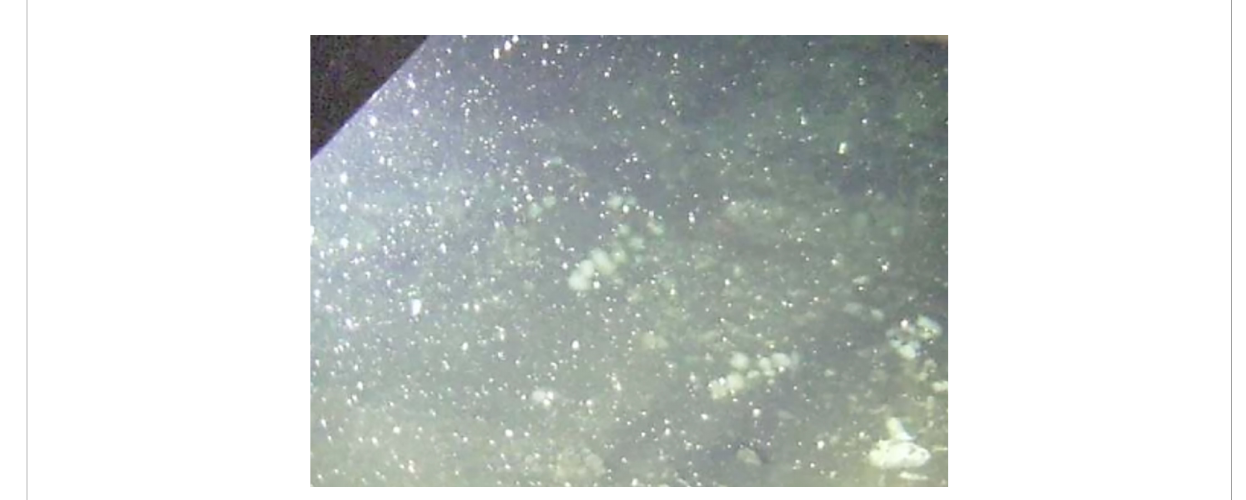
FIGURE 4 Lateral advection of disintegrated gelatinous particles, as an example of a rare biomass input from shallower waters. Note the technical dif fi culties in determining the depth of view and the shape of the particles, and as a result, the challenging estimation of their size in order to calculate fl uxes.